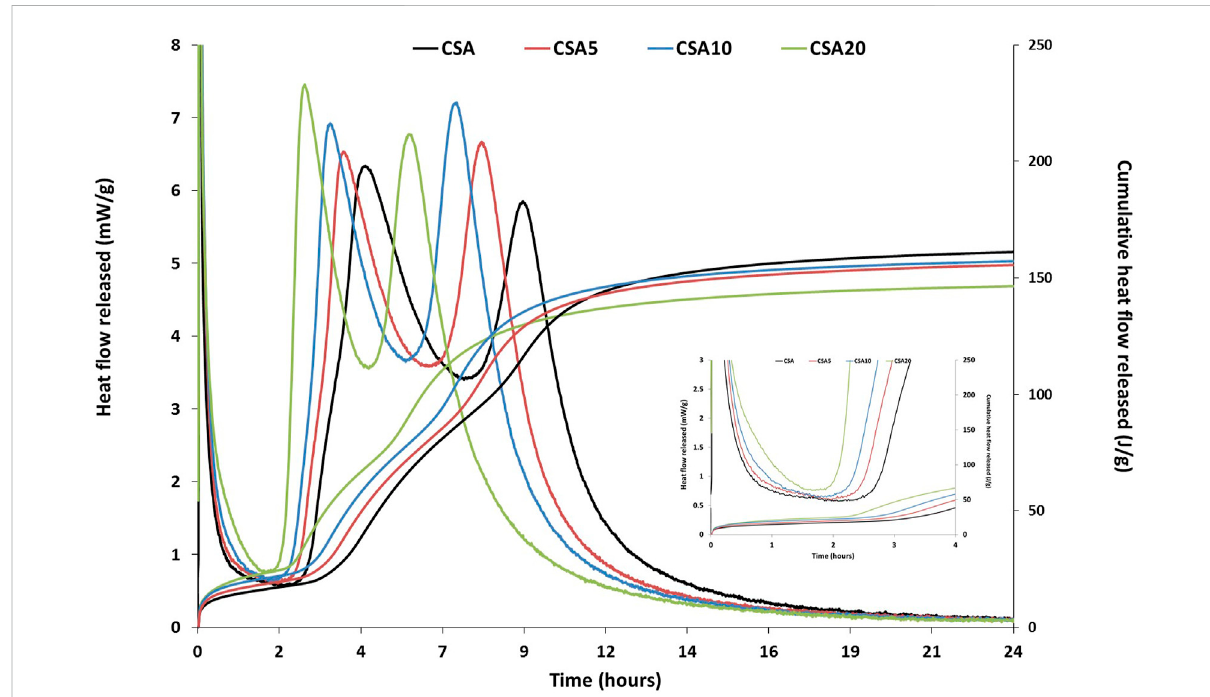
FIGURE 5 Heat fl ow and cumulative heat released for the four cement pastes: CSA, CSA5, CSA10, and CSA20.